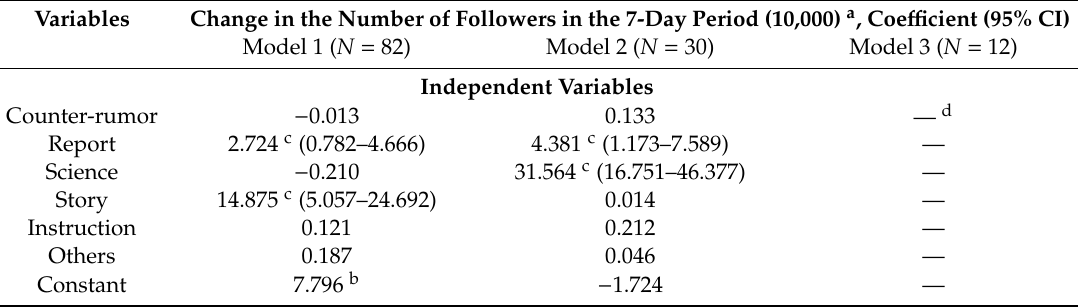
Table 6. Multiple linear regression result.